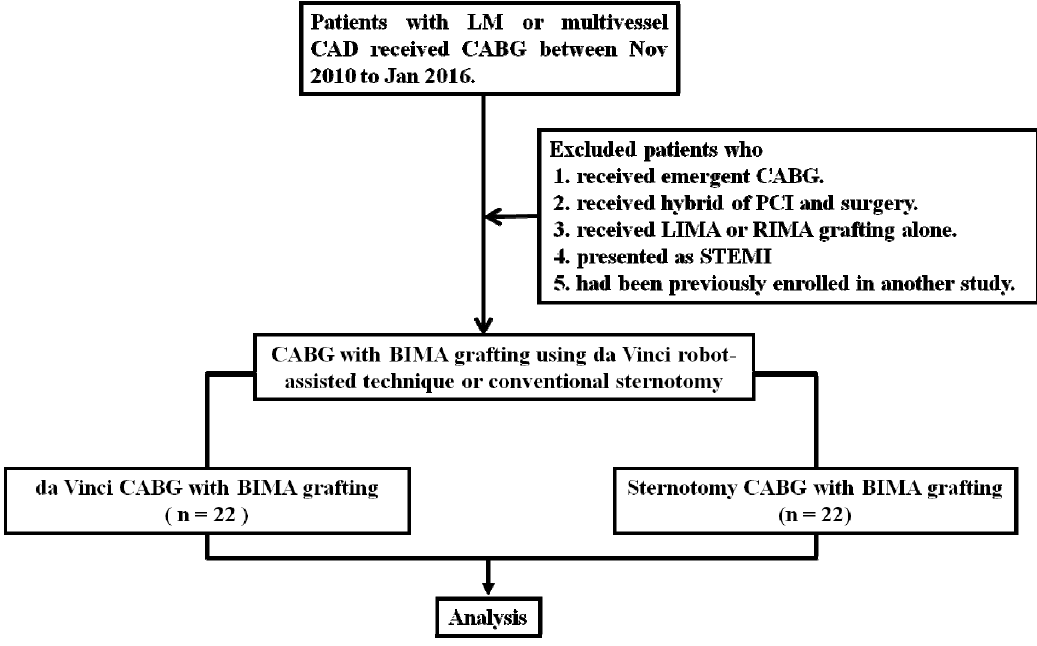
Figure 1. The patient flow chart. LM = left main; CABG = coronary artery bypass grafting; CAD = coronary artery disease; PCI = percutaneous coronary intervention; LIMA = left internal mammary artery; RIMA = right internal mammary artery; STEMI = ST-segment elevation myocardial infarction; BIMA = bilateral internal mammary artery.